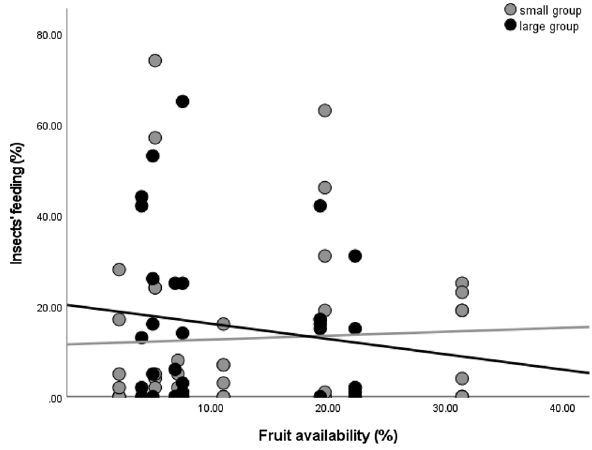
Figure 3. Group comparison for percentages of time spent feeding on insect in relation to fruit availability. Fruit availability is measured as monthly phenological score (see “Methods”). Each dot indicates the average monthly percentage of time spent feeding on insect for each focal individual. The lines are best-fit-lines for each group data